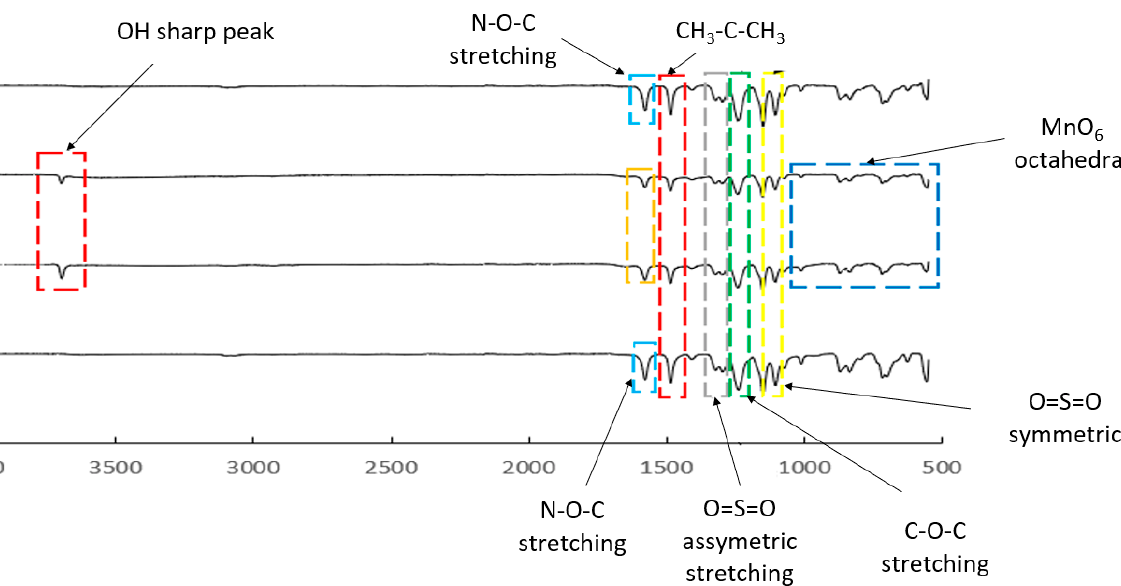
Figure 5. FTIR spectra of ( a ) PES 0, ( b ) PES 1, ( c ) PES 3, and ( d ) PES 5 membranes.